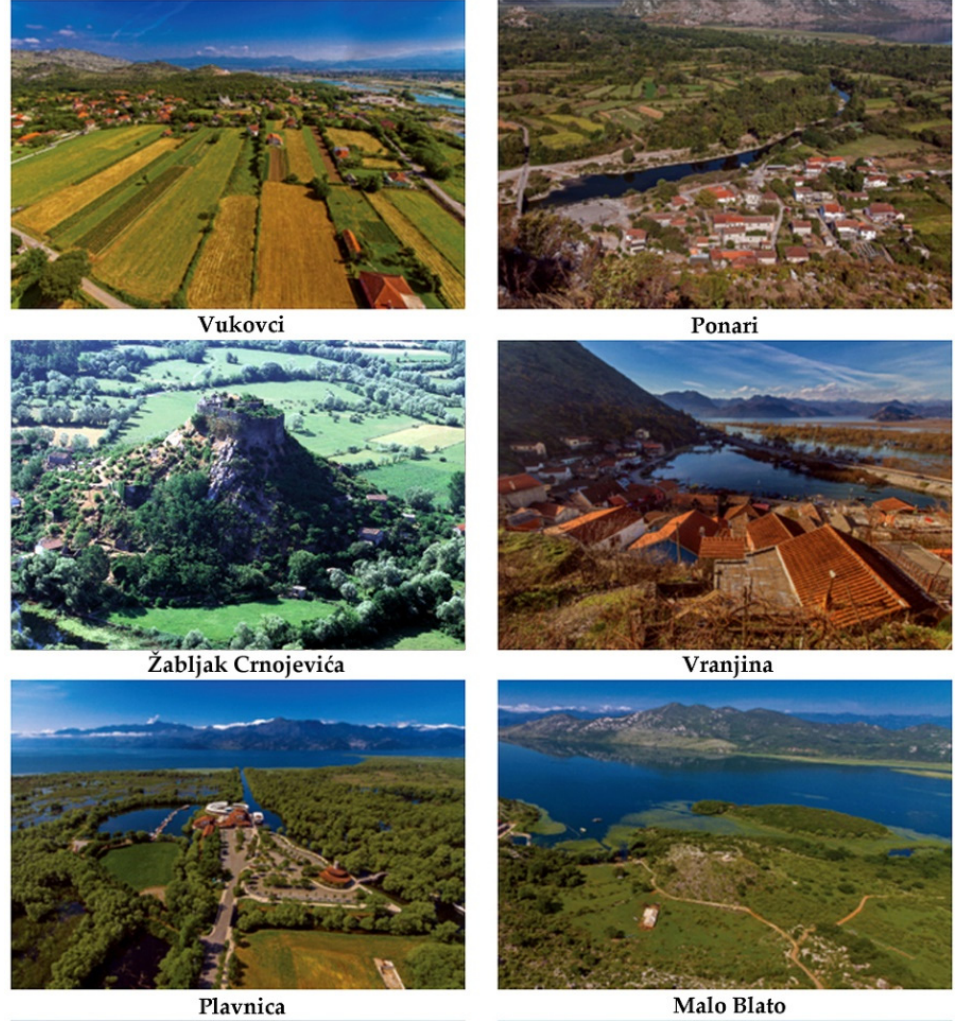
Figure 3. Panoramic view on some parts of the Zeta region, Montenegro (Photo: D. Star č evi ć ).